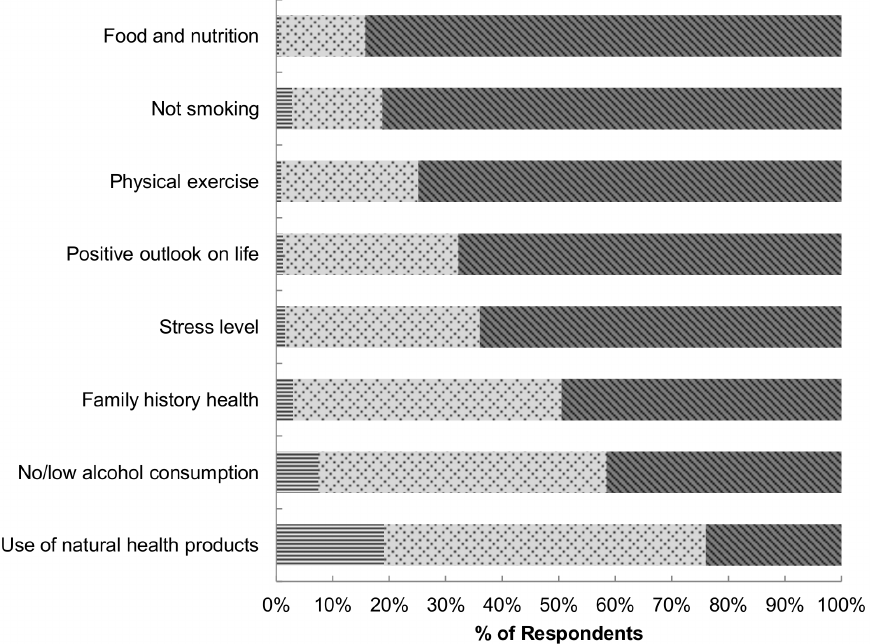
Figure 2. Perceived importance of factors related to maintaining or improving one’s own health* by CCM respondents { (N=6,665). *1=not at all important; and 7=extremely important: 1–2; 3–5; and 6–7. { Respondents were weighted to be representative of the Canadian population by age, sex, and province according to the 2006 census data. CCM: Canadian Consumer Monitor. Survey question: Using the following scale, please indicate how important you consider each of the following for maintaining or improving your own overall health. (Note: natural health products in Canada typically refer to herbal medicines or vitamin or mineral supplements).